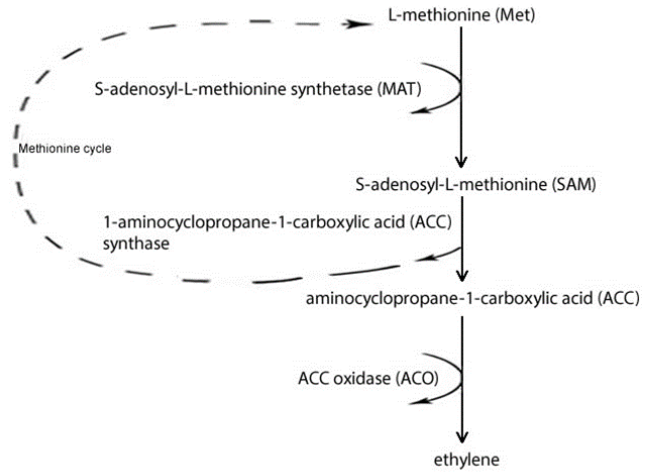
Figure 1. Ethylene biosynthesis in peach [38]. This ethylene formation is oxygen-dependent, while under anaerobic conditions eth- ylene production is not observed [33,38]. Aminoethoxyvinylglycine (AVG) acts as a com- petitive inhibitor to the conversion of SAM into ACC, by stopping ACS activity and slow- ing down the softening process in peach post-harvest without an effect on its quality traits [39]. Conversely, the use of ethephon, resulting in a persistent ethylene release, was found to enhance fruit ripening and cause abscission [40]. The hormone ABA interacts with ethylene, the cell wall and auxin-related genes in peach [41]. In climacteric fruits, it accumulates before ethylene production and reaches maximum levels in fully ripe fruits. Furthermore, ABA enhances anthocyanin and sugar accumulation, promotes softening and is associated with increased ethylene biosynthesis [41]. Fatty acids (FAs) are another compound category whose composition changes dur- ing peach fruit ripening and has an important influence on aroma production. FA biosyn- thesis relies on enzymes including lipoxygenases (LOXs), hydroperoxide lyases (HPLs), alcohol dehydrogenases (ADHs), alcohol acyltransferases (AATs) and fatty acid desatu- rases (FADs) [5]. LOXs catalyse oxidation of polyunsaturated fatty acids, like linoleic and linolenic acids, which accumulate during fruit ripening. Concentrations of linoleic acid were found to increase after peach harvest and then decrease during storage at 20 °C. Linolenic acid increased during the post-harvest ripening phase, especially after about one week. Conversely, palmitic acid showed a two-fold decrease over the same period, while the concentrations of other fatty acids, such as stearic and oleic acid showed no major changes [5]. LOX is responsible for catalysing the hydroperoxidation of polyunsaturated fatty ac- ids to start the synthesis of oxylipins [42]. In particular, jasmonates (JAs) are a class of oxylipins that slow down the peach ripening process, often considered as a reference to investigate the effects of this hormone [43], and they are also responsible for an interfer- ence between ripening and stress defence genes [44]. Alterations in the ripening physiol- ogy may be related to effects of MJA (Methyl JAsmonate) treatment, often used to delay natural fruit decay [45], to prevent CI after harvesting [46] and inhibit pathogens [47]. Specifically, MJA causes a reduction of the expression levels of the genes responsible for the ripening process and that are found at high levels in this phase, with some also in- volved in ethylene biosynthesis (e.g., ACO1 ) [35].